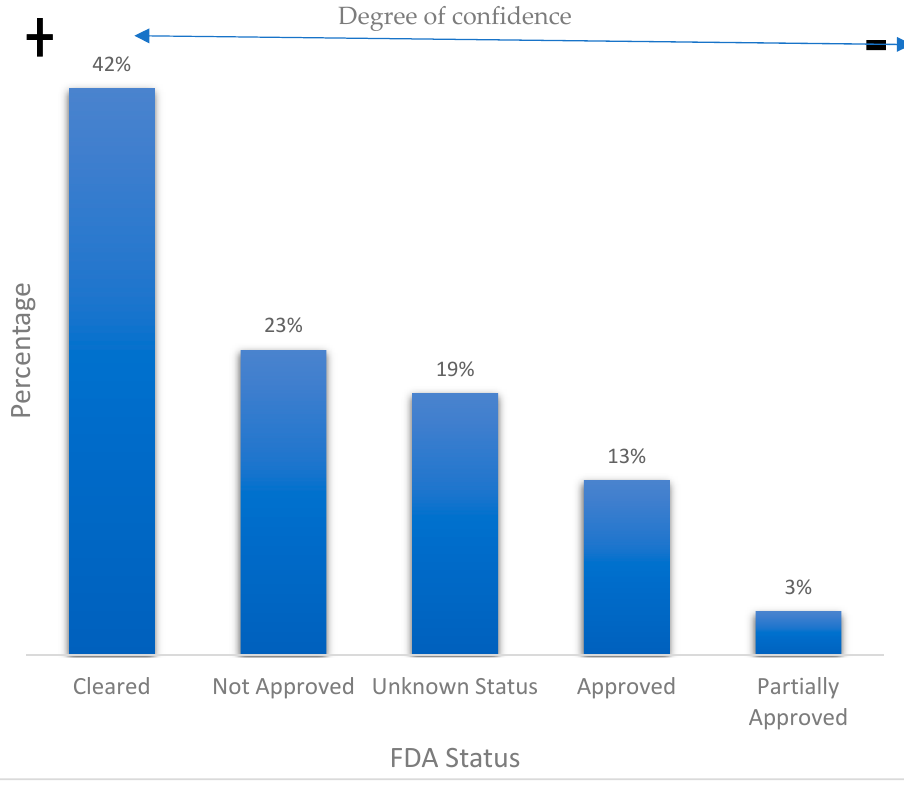
Figure 4. FDA status of commercial wearable devices for CVD monitoring.